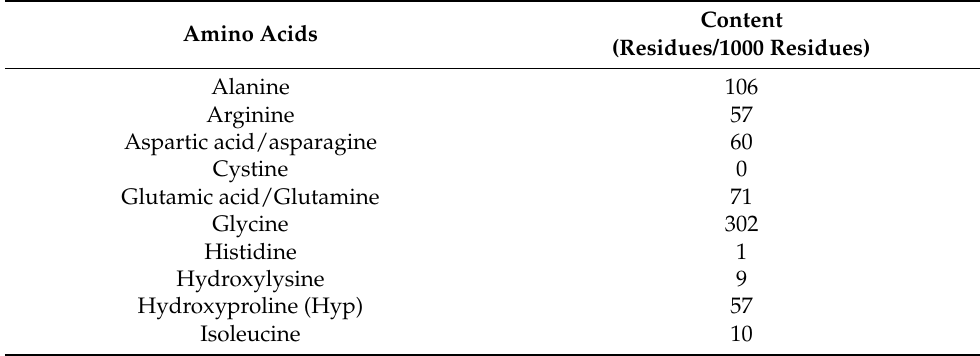
Table 2. Amino acid composition of acid-soluble collagen from salmon skin prepared by washing a collagen pellet using distilled water for three cycles